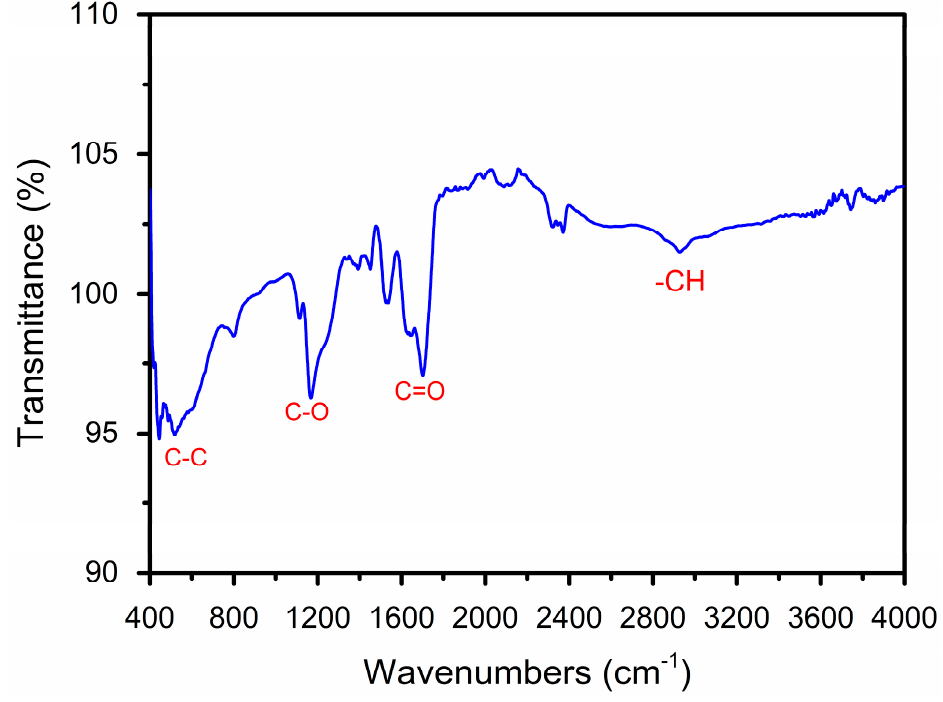
Figure 2. Fourier transform infrared (FTIR) spectral analysis of BCE hydrogel adsorbent.